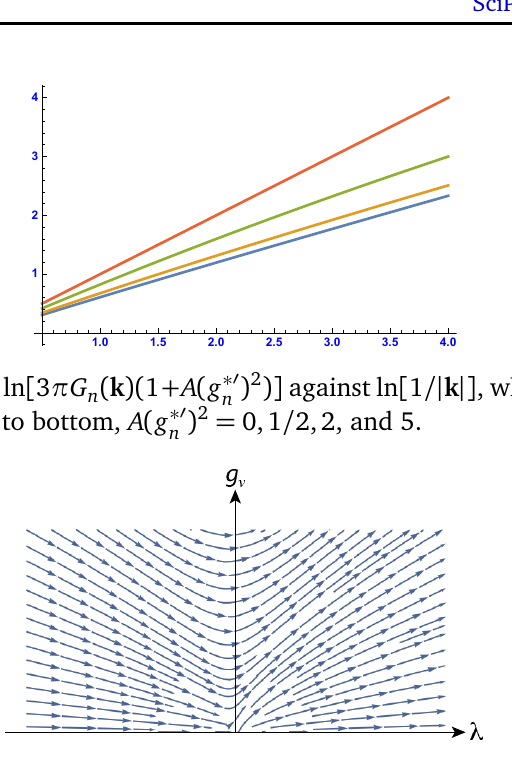
Figure 2: The plot of ln [ 3 π G by Eq. 20. From top to bottom, A ( g ∗(cid:48)